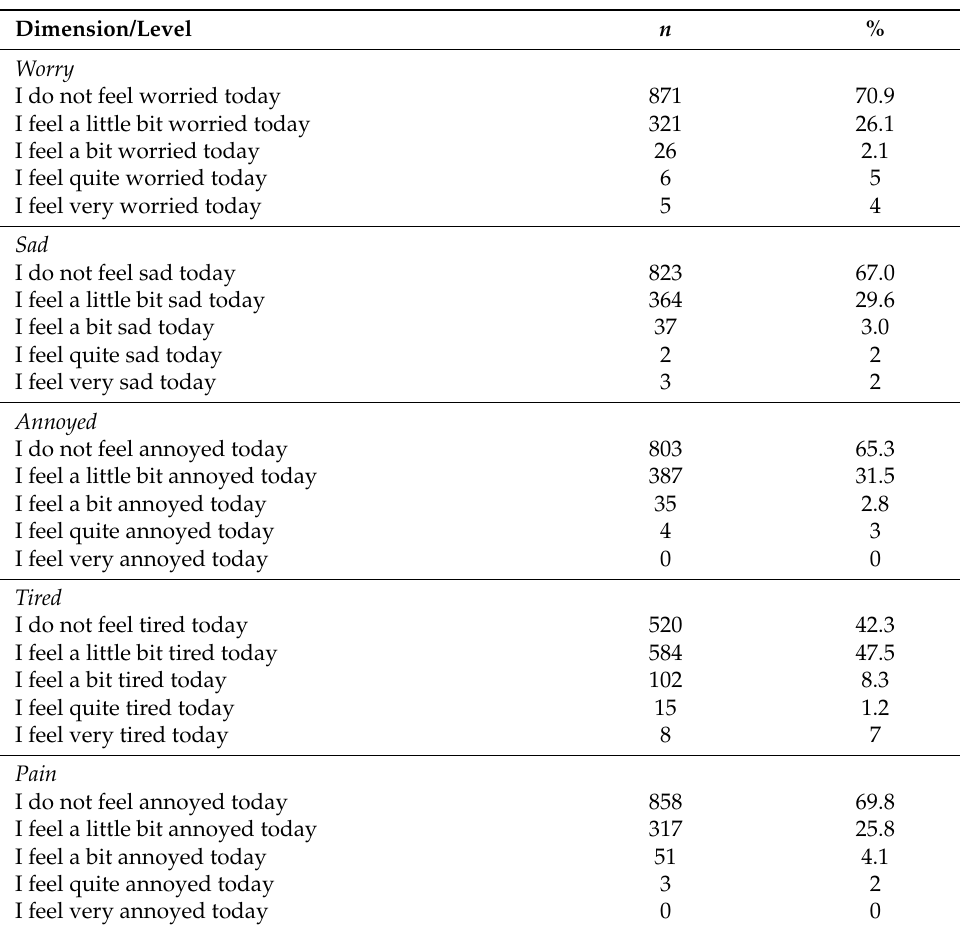
Table 2. Responses to the Child Health Utility 9D.